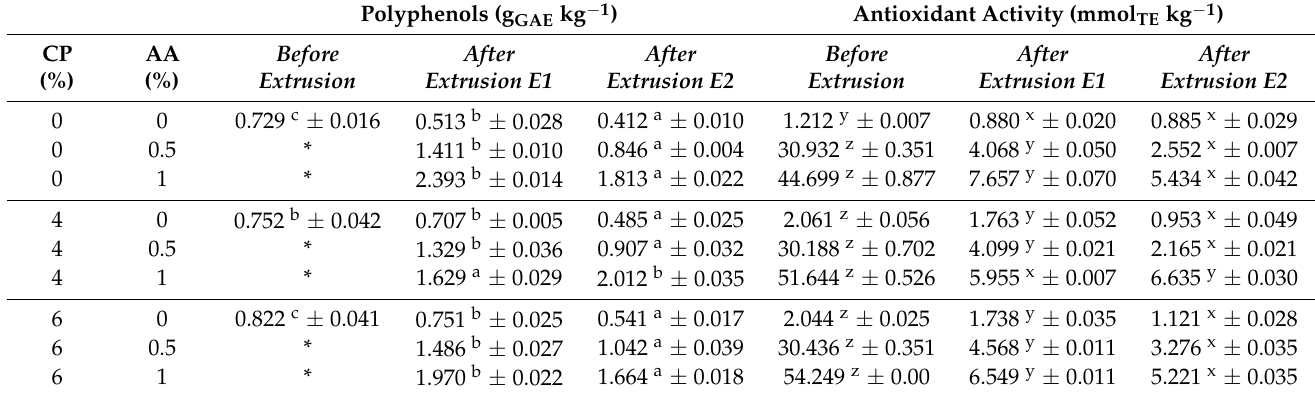
Table 3. Polyphenols and antioxidant activity in raw and extruded samples A,B